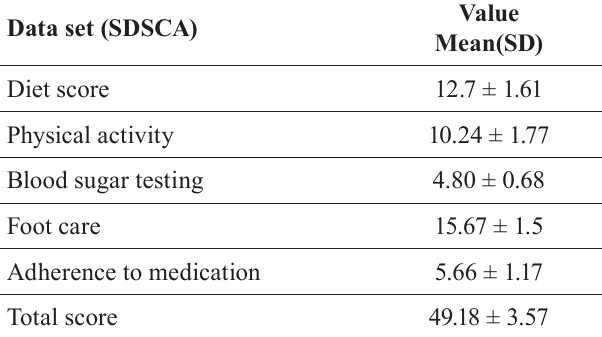
TABLE IV - Summary of Diabetes Self-Care Activities (SDSCA) data among patients with diabetes mellitus in Warangal, India (n = 402)